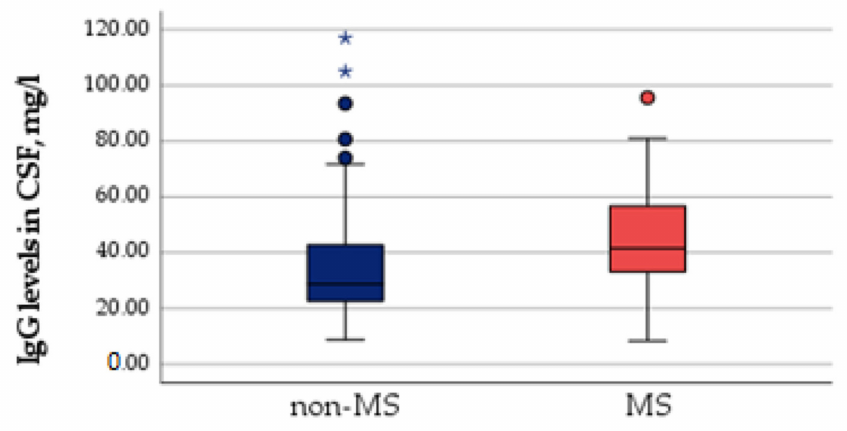
Figure 1. IgG levels in cerebrospinal fluid and conversion to MS. * Statistically significant differences are expressed in the bold type ( p < 0.05).